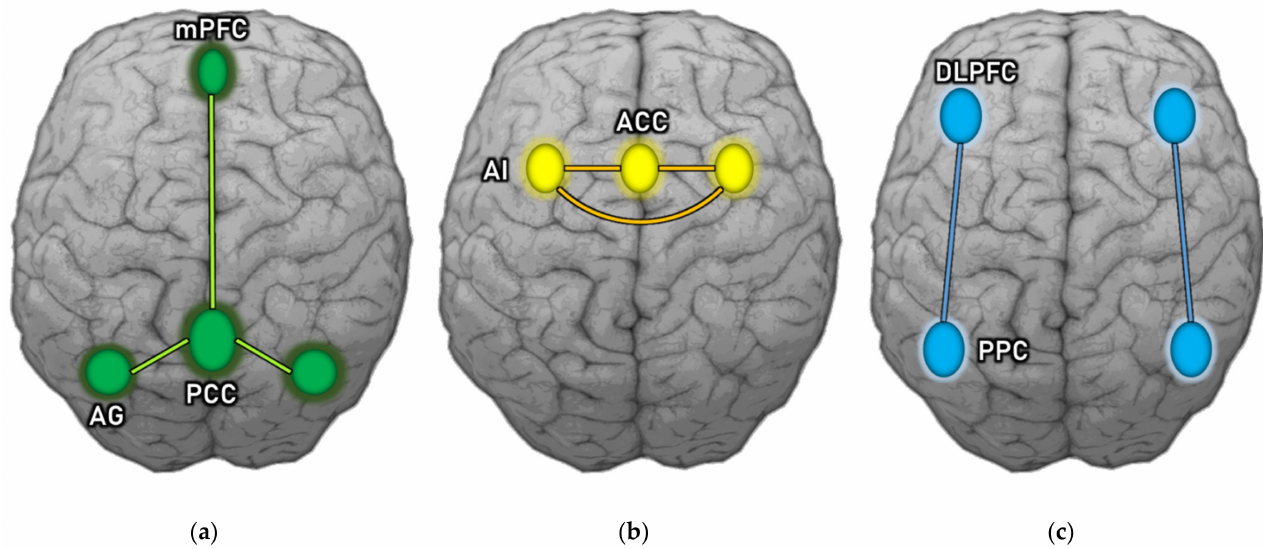
Figure 3. “Triple network”: ( a ) Default mode network; ( b ) Salience network; ( c ) Central executive network. AG—Angular gyrus; mPFC—medial prefrontal cortex; PCC—Posterior cingulate cortex; AI—Anterior insula; ACC—Anterior cingulate cortex; DLPFC—Dorsolateral prefrontal cortex; PPC—Posterior parietal